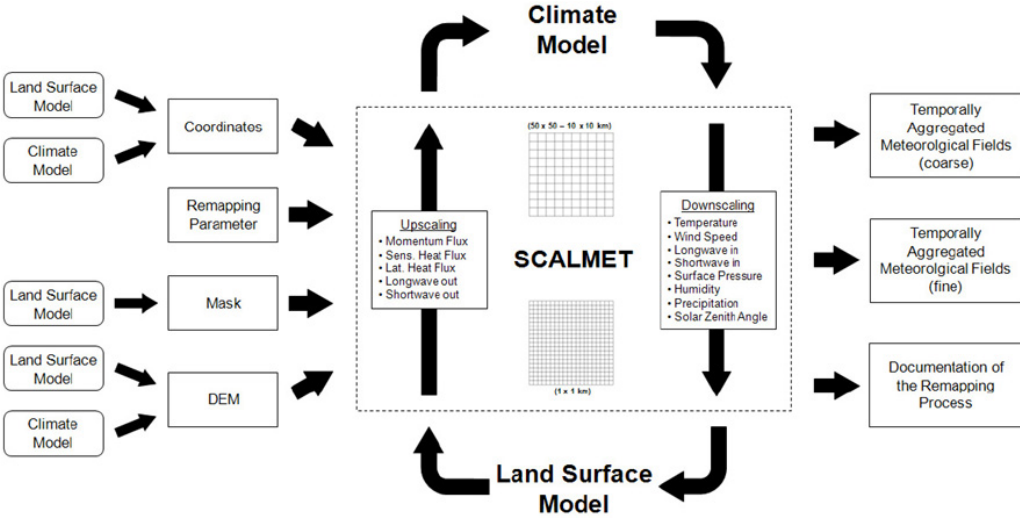
Figure 2. Schematic overview of the coupled model SCALMET (Marke, 2008, p. 41).